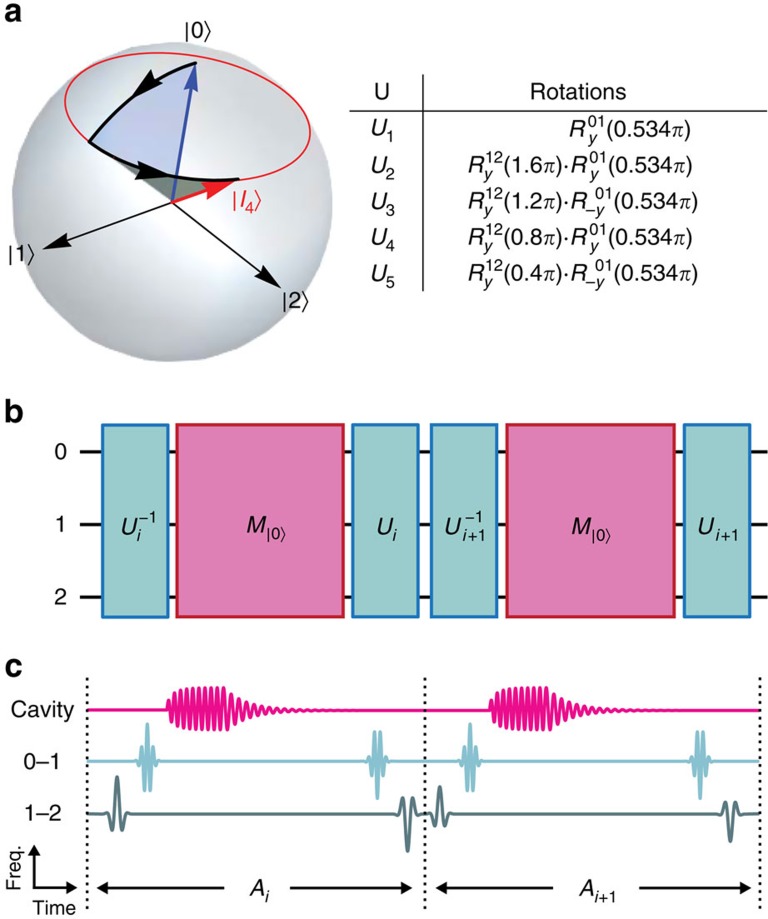
Measurement potocol.(a) Unitary transformations of the qutrit ground state to the KCBS states. Each Ui can be decomposed into one or two rotations , where ϕ is a rotation of angle about the axis  in the qutrit subspace spanned by {|i〉, |i+1〉}. The rightmost pulse in a product is applied first in time. The trajectory of the state under transformation U4 is shown as an example. (b) The measurement protocol includes two sequential projecting measurements M|0〉 onto the ground state with unitary transformations before and after each measurement. The unitaries rotate the measurement axis into one of the states of the KCBS pentagram. (c) The actual experimental sequence for each pair of measurements. Measurement of the M|0〉 observable is implemented with a cavity probe signal and the qutrit rotations  are constructed with microwave pulses applied at the qutrit transition frequencies.